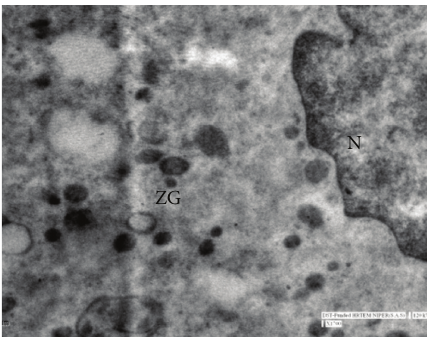
Figure 4: Electron micrograph 7.5cm CVRL (62 days) showing nucleus (N), developing zymogen granules (ZG), and some of the empty vesicles (EV) in acinar cell × 1700.